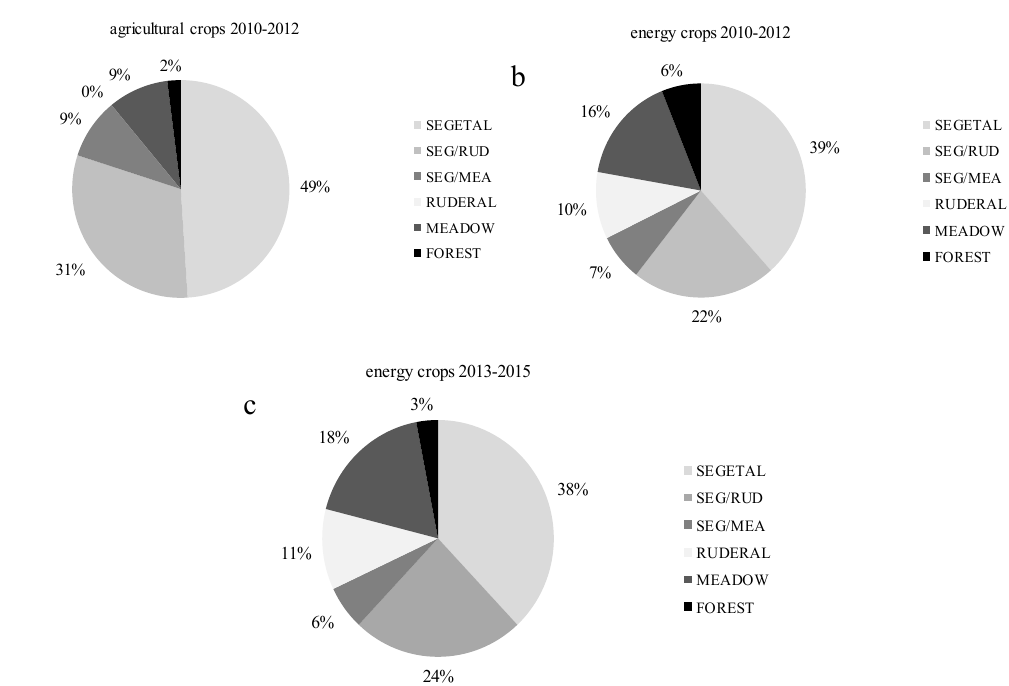
Figure 9. Percentage share of species from different habitats in plant communities accompanying annual agricultural crops and energy crops. (a) agricultural crops in the years 2010-2012, (b) energy crops in the years 2010-2012, (c) energy crops in the years 2013-2015.